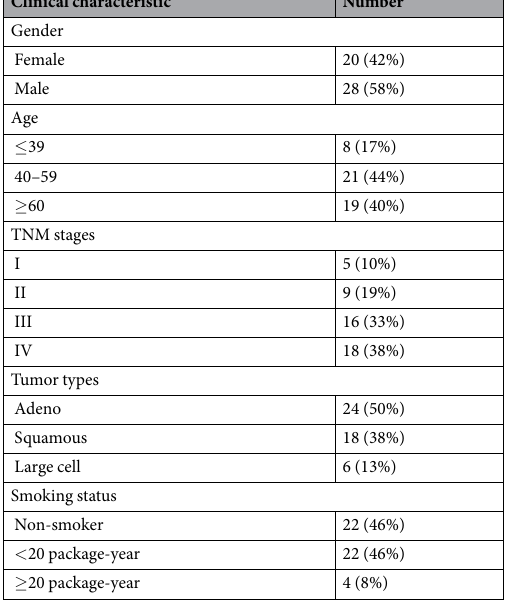
Table 1. Clinical characteristics of the 48 NSCLC patients.